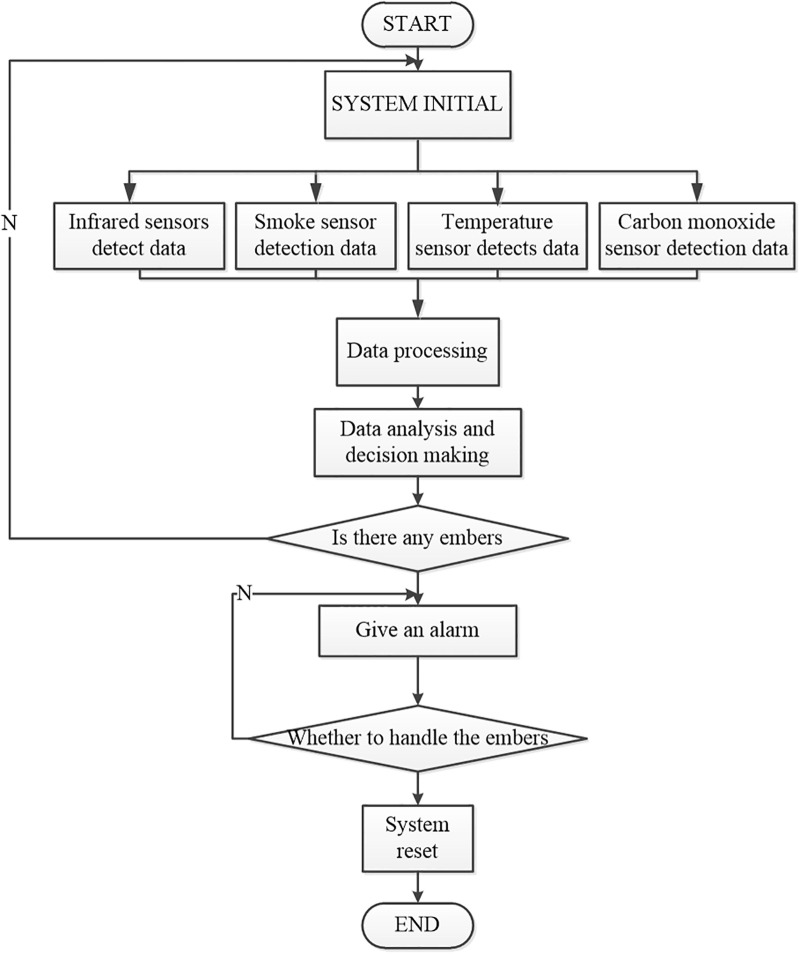
Flowchart of the detection system for forest remaining fires.